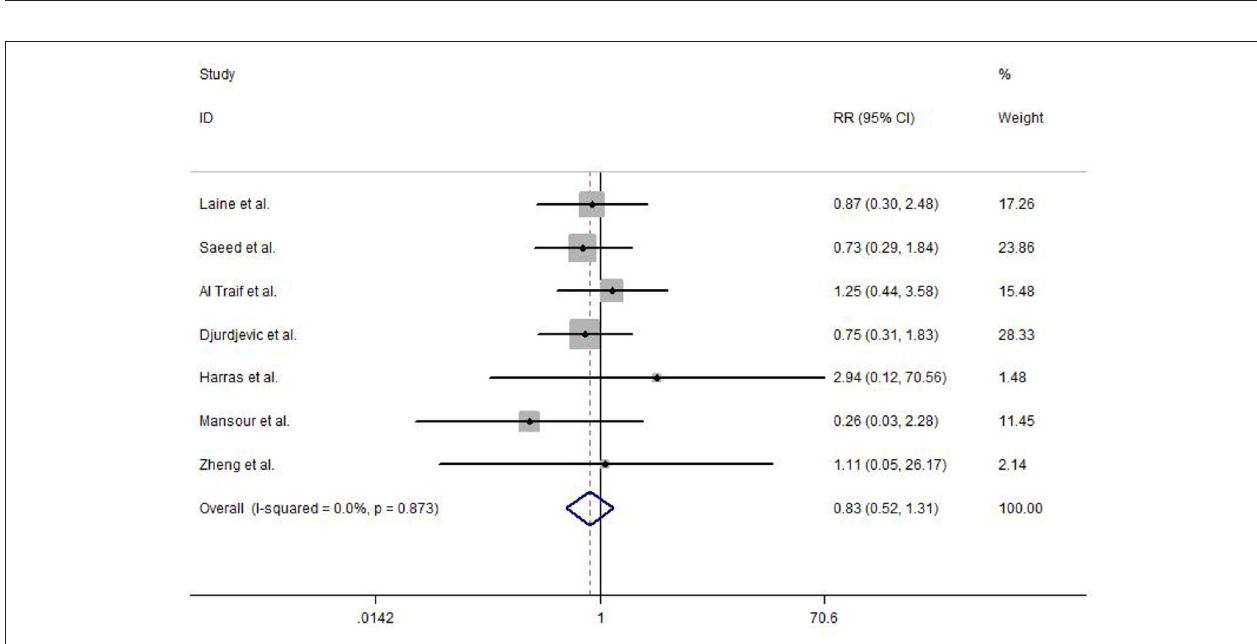
FIGURE 4 | Forest plot of the meta-analysis comparing EVL and EVL + EIS with respect to the efficacy of acute bleeding control. EIS, endoscopic injection sclerotherapy; EVL, endoscopic variceal ligation.